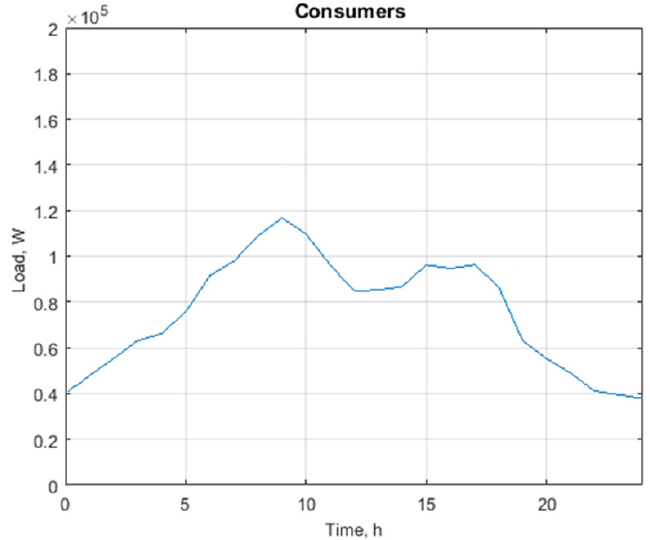
Figure 10. Load schedule in the CLN during the day.